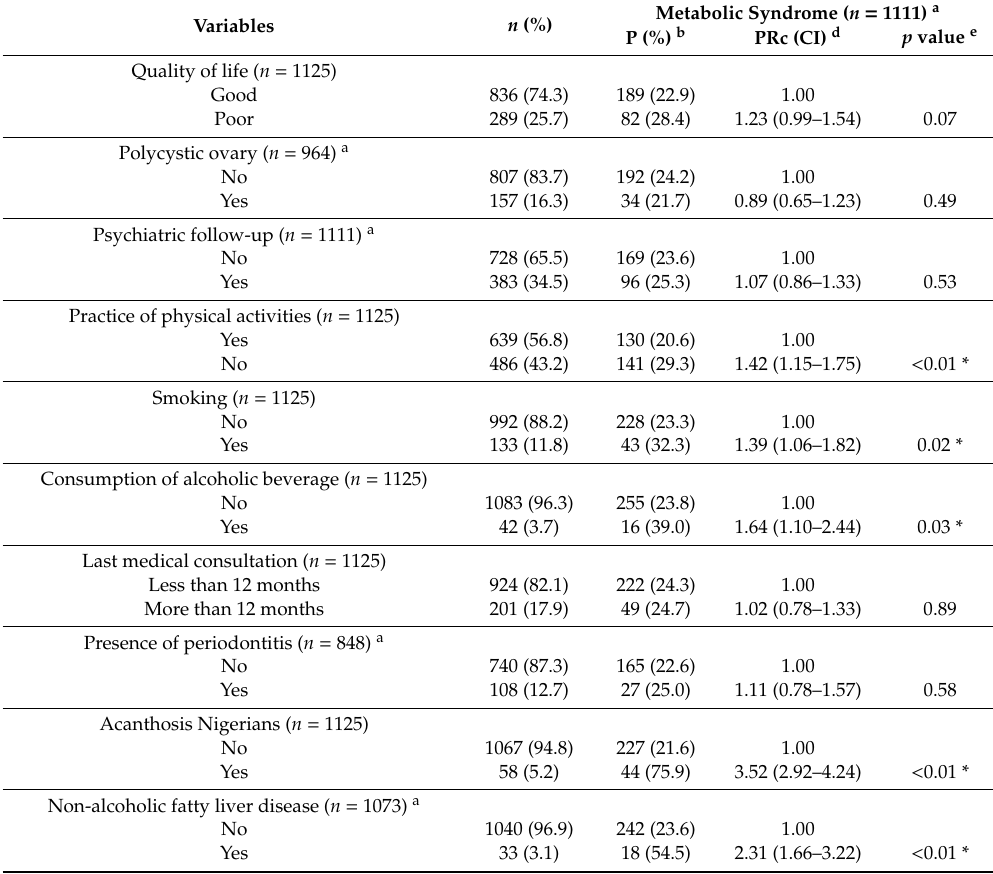
Table 2. Prevalence of metabolic syndrome according to lifestyle and human biology variables in primary health care nursing professionals, Bahia, Brazil, 2018, ( n =